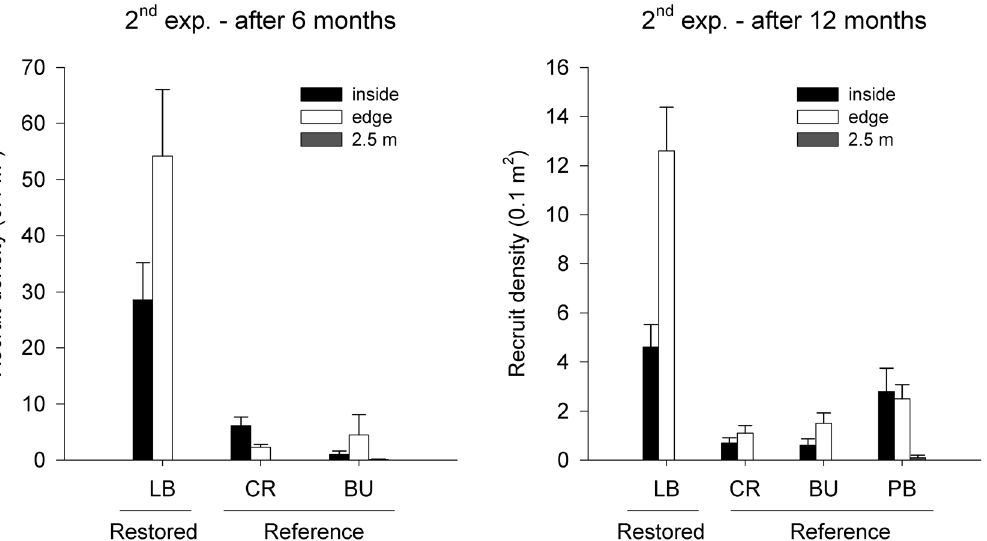
Figure 4. Mean ( ± S.E.) densities of recruits inside (black bars), at the edge of ( , 30 cm from a patch; white bars) or 2.5 m away from (grey bars) patches of Phyllospora at the restored place Long Bay (LB; n =5) and at reference places (CR, Cronulla, BU, Bundeena, PB, Palm Beach; n =10) after 6 and 12 months from the start of the second experiment.